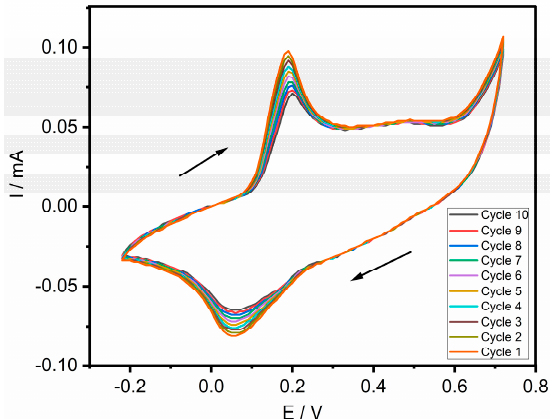
Figure 2. Electroplating polyaniline (PANI) film in an aqueous solution of 1.0 M HCl + 0.3 M aniline by cyclic voltammetry.